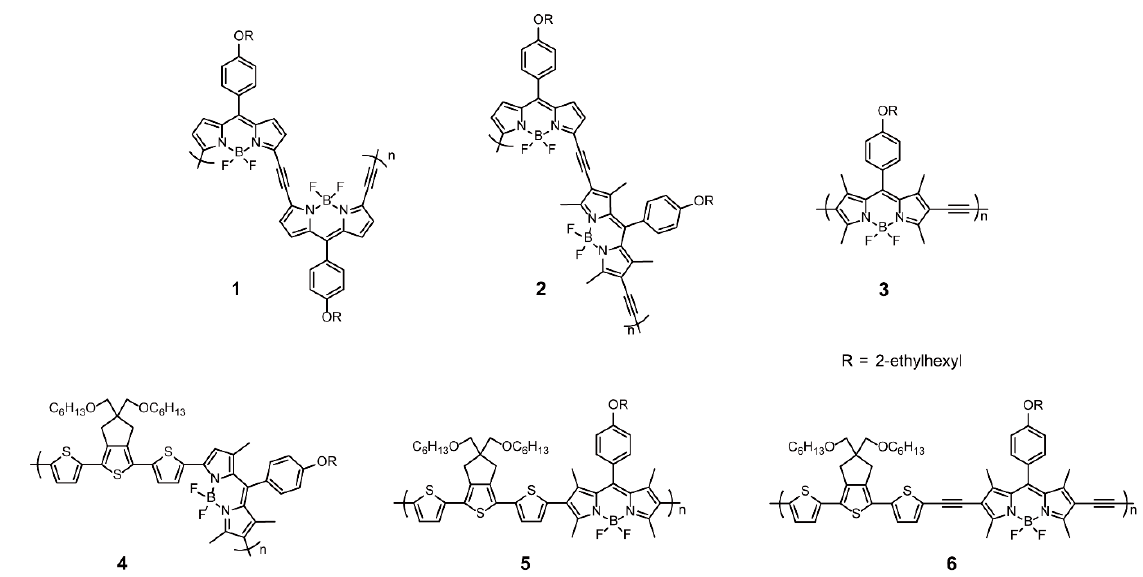
Figure 2. Chemical structures of polymers 1–6 (Reproduced with permission from Reference [30]. Copyright @ 2016, John Wiley and Sons. Reproduced with permission from Reference [31]. Copyright @ 2015, American Chemical Society).